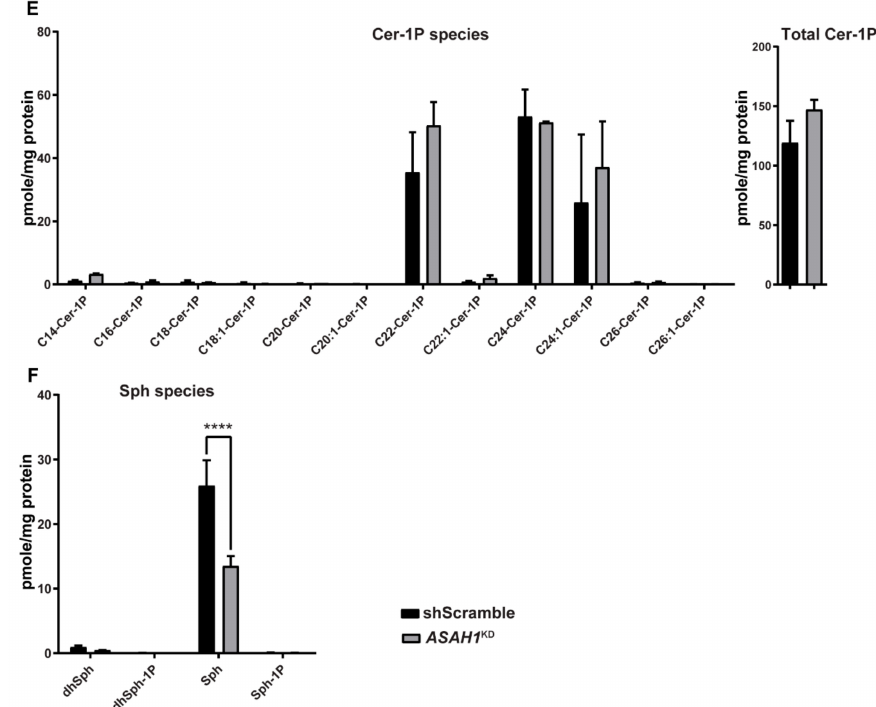
Figure 9. AC depletion causes changes in sphingolipid content. HPLC-MS / MS quantification analysis of the intracellular levels of di ff erent subspecies of medium- and longer-chain sphingolipids in shScramble (black color) and ASAH1 KD (grey color) cells: ( A ) ceramide (Cer), ( B ) dihydroceramide (dhCer), ( C ) hexosylceramide (HexCer), ( D ) sphingomyelin (SM), ( E ) ceramide-1-phosphate (Cer-1P) and ( F ) dihydrosphingosine (dhSph), dihydrosphingosine-1-phospate (dhSph-1P), sphingosine